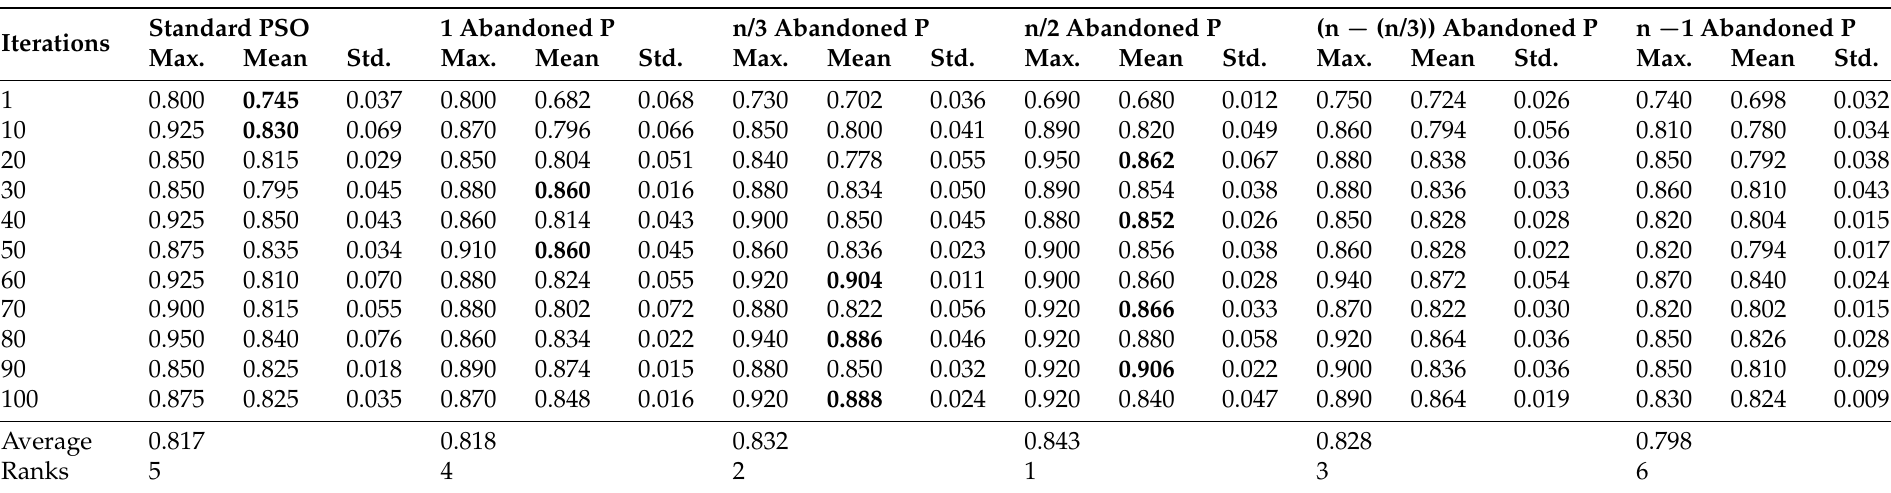
Table 4. Different number of abandoned particles with least solutions of subswarm-PSO for 20